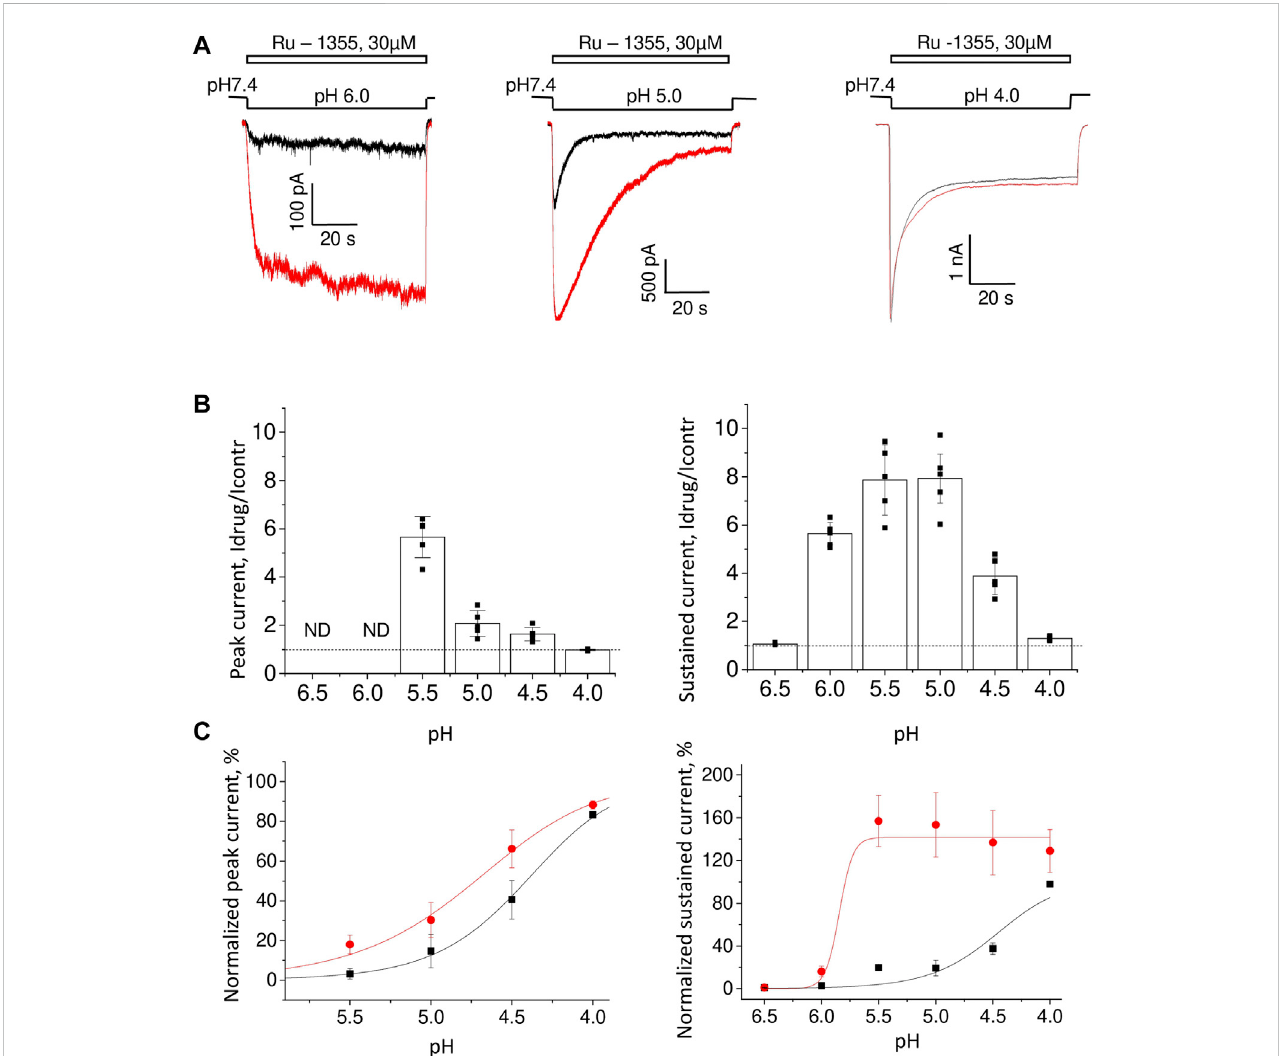
FIGURE 5 The pH dependence of Ru-1355 action on ASIC2a. (A) , representative responses evoked by different acidi fi cations in the control condition (black) and in the presence of 30 μ M Ru-1355 (red). Responses to pH 6.0 and 5.0 are strongly potentiated, whereas at pH 4.0, only minor potentiation of the sustained current isdetected. (B) , summarydata for theRu-1355effect onpeakand sustained componentsoftheresponse. Thepeakcomponentisnotpronouncedat pH 6.5 and 6.0. In both cases, the drug becomes ineffective at strong acidi fi cations. (C) , Ru-1355 produces an apparent shift of pH 50 for both peak (left) and steady-state (right) components of the